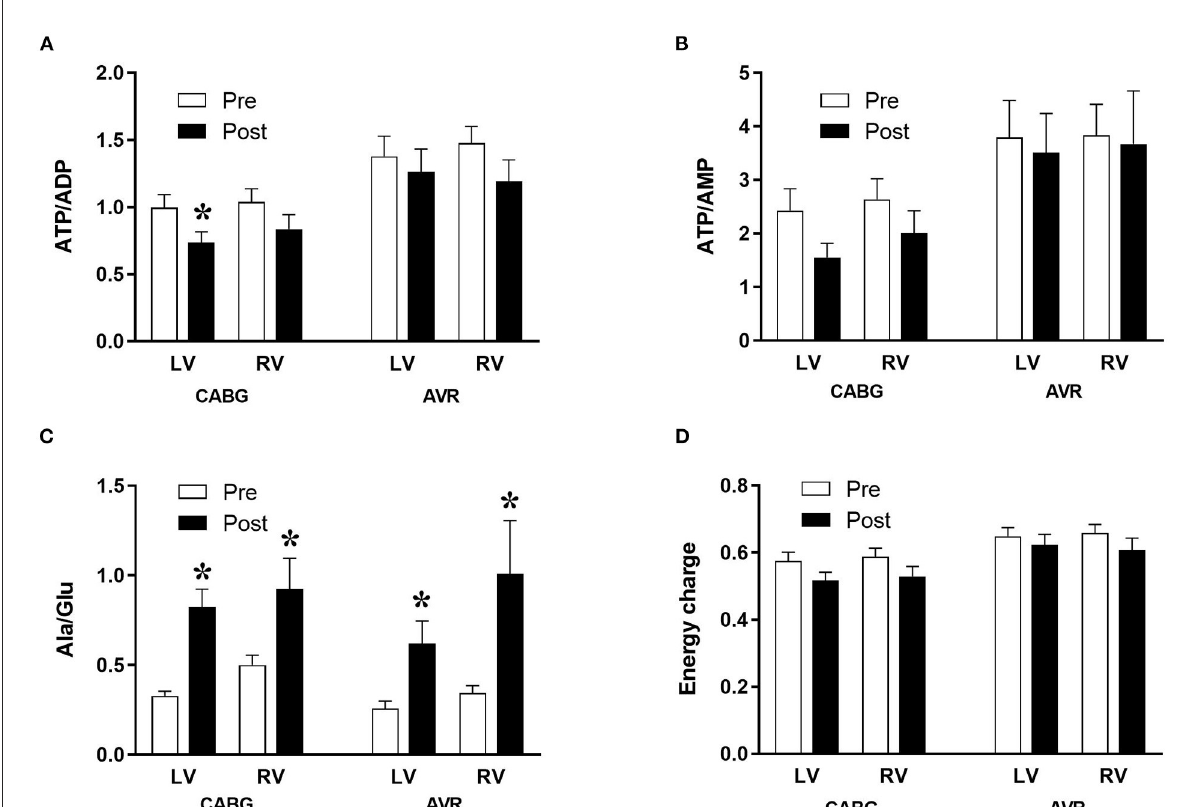
FIGURE1 Metabolic ischemic stress in CABG and AVR patients. Values are mean ± SEM for ATP/ADP (A) , ATP/AMP (B) , Ala/Glu (C) , and Energy charge (D) in left (LV) and right (RV) ventricles of patients pre- (white) and post- (black) cardioplegic arrest in CABG or AVR surgery. * Represents a significant difference vs. corresponding pre samples (unpaired two-tailed student’s t -test or Mann-Whitney U -test as